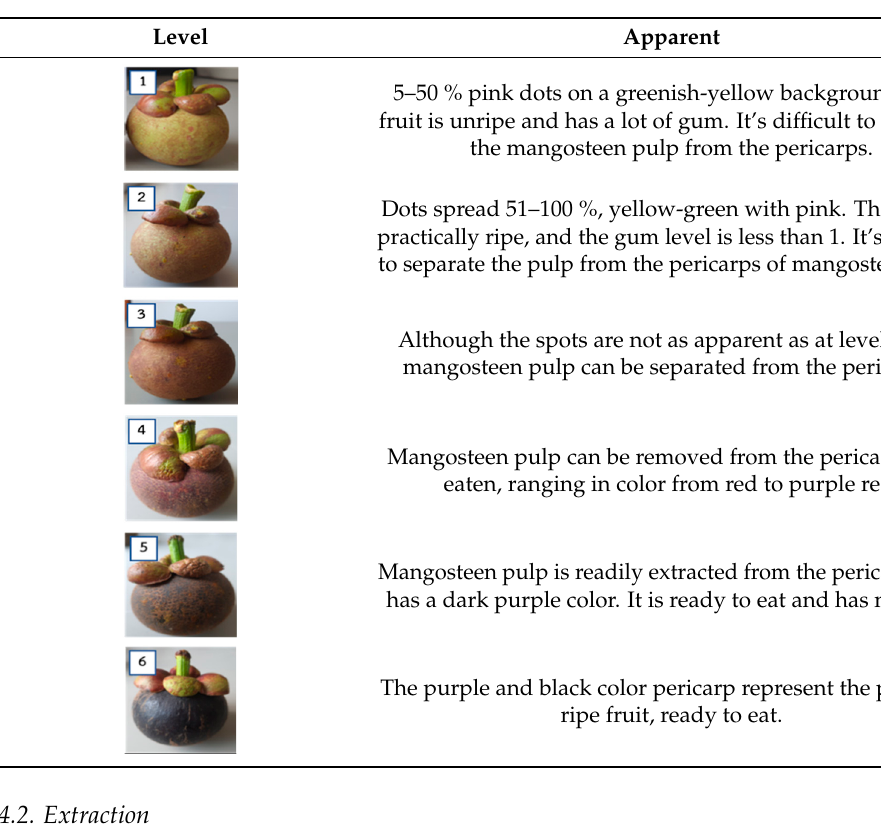
Table 2. The mangosteen ripening in all six levels.